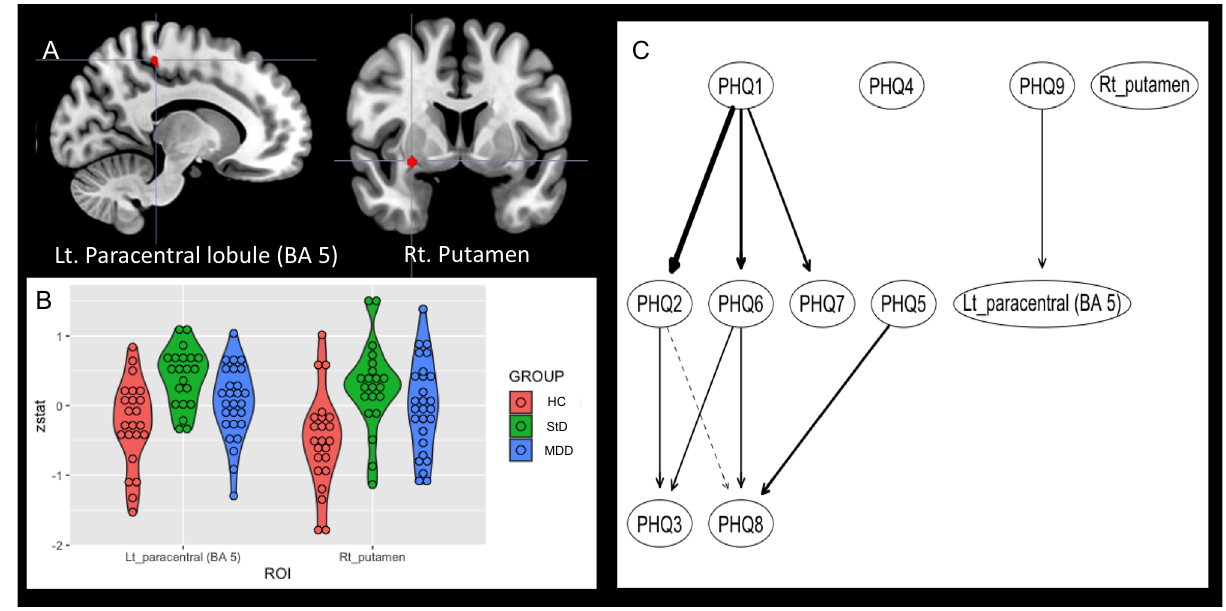
Figure 3. Between-group differences of functional brain activation for conflict control of incongruence trial against smaller monetary loss, compared to the congruence trial of target-response location. Subthreshold depression (StD) demonstrated higher functional activation of left paracentral lobule compared to healthy control (HC). Also, higher functional activation of right putamen was found in StD and major depressive disorder (MDD) compared to HC. ( A ) Clusters of brain functional activation with significant between-group differences (cluster-forming thresholds of P < 0.001 and k ≥ 10). ( B ) Violin plots of z-stats per clusters per group. ( C ) Directed acyclic graph that represents conditional independence associations among depressive symptoms [9 items of Patient-Health Questionnaire-9 (PHQ-9)] and z-stats of 2 brain clusters. Directional association from suicidal ideation to functional activation of left paracentral lobule was found. PHQ-1 sadness, PHQ2 anhedonia, PHQ3 sleep disturbance, PHQ4 appetite change, PHQ5 psychomotor change, PHQ6 fatigue, PHQ7 self-reproach, PHQ8 concentration difficulty, PHQ9 suicidal ideation, Lt left, BA Brodmann